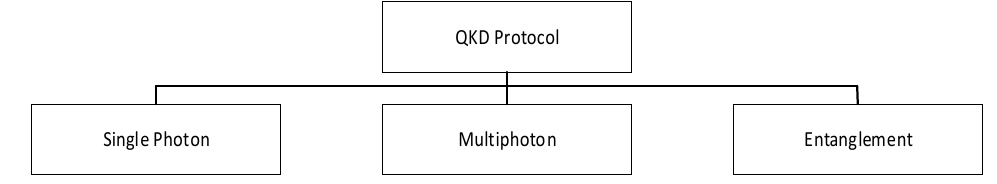
Figure 2. Categories of QKD Protocols .